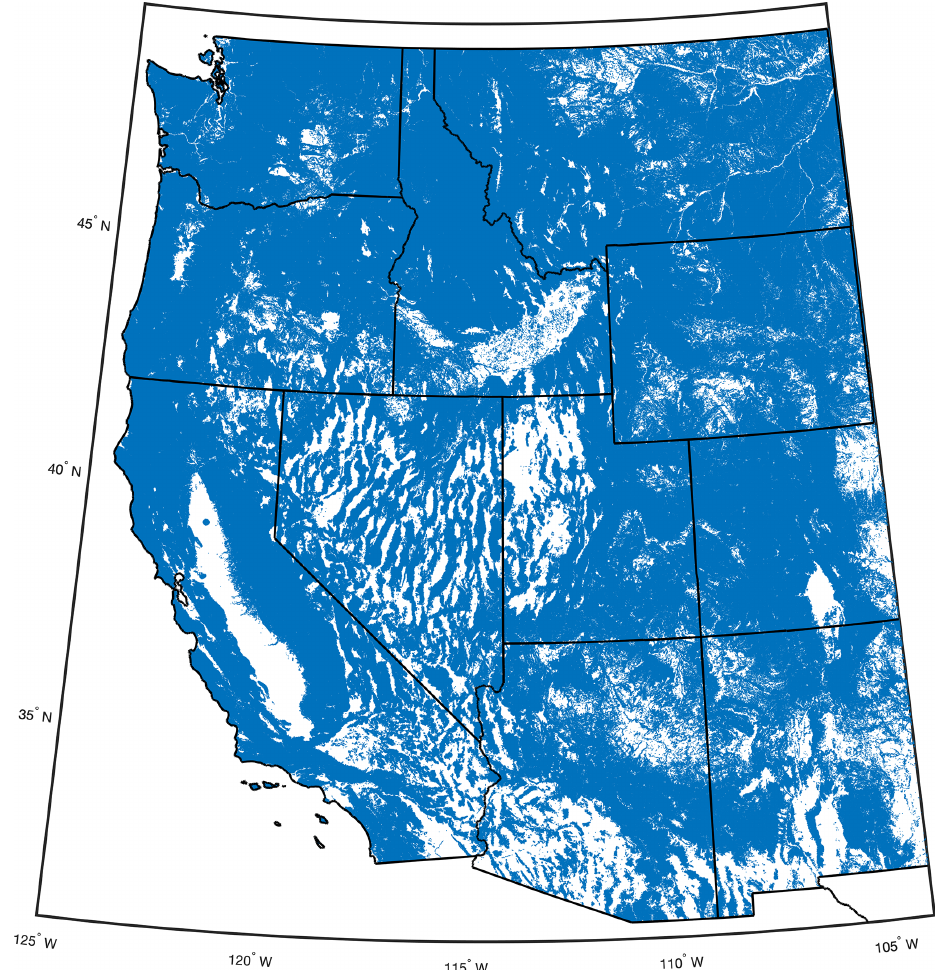
Figure B1. Map of the 3.1million square kilometer modeling domain with locations modeled at 210m spatial resolution shown in